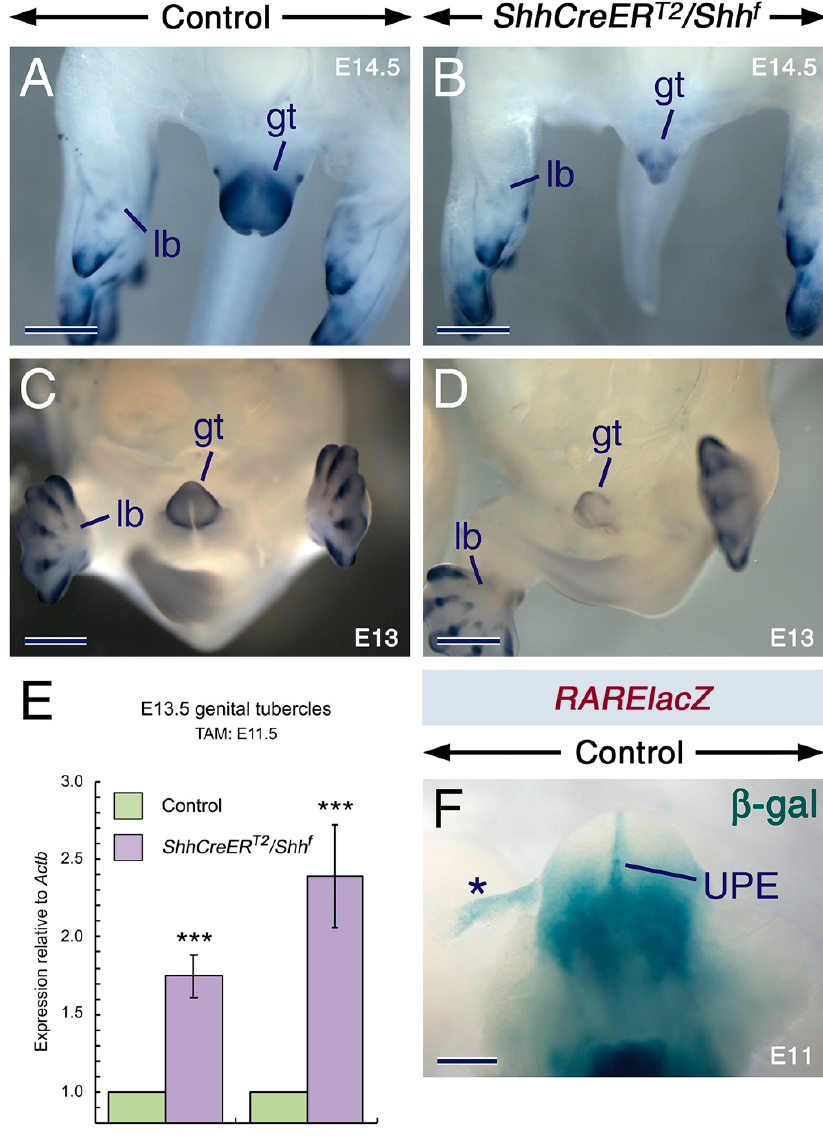
Figure 6. Loss of SHH signaling in the developing genital tubercle causes downregulation of Cyp26b1 expression and enhancement of retinoic acid signaling. ( A – D ) Representative Cyp26b1 whole-mount in situ hybridization with riboprobes (purple). E14.5 control ( A ; n = 2) and ShhCreER T2 / Shh f mutant ( B ; n = 2) embryos first exposed to tamoxifen (TAM) at E12. E13 control ( C ; n = 2) and ShhCreER T2 / Shh f mutant ( D ; n = 2) embryos first exposed to TAM at E11.5. Diminished Cyp26b1 hybridization signals in the genital tubercle (gt) of the mutants. Note that Cyp26b1 signals are not altered in chondrogenic condensations within limb buds (lb) of the mutant as these cellular condensations do not express Shh . ( E ) RT-qPCR analysis for RARb and RARg relative to Actb ( β -actin) in genital tubercles from E13.5